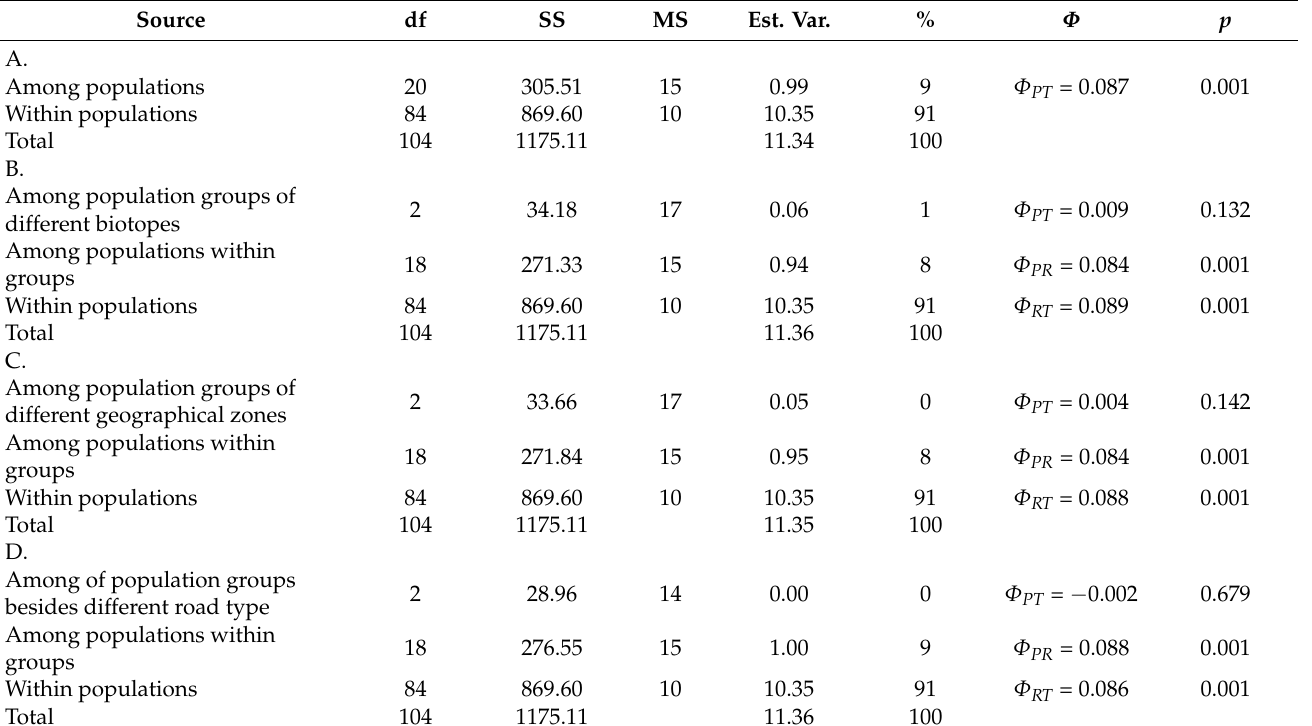
Table 3. Analysis of AFLP loci variance for small balsam ( Impatiens parviflora ) populations. A . Two- level analysis. B – D . Three-level analyses, differentiation of populations in relation to biotope ( B ), geographical zone ( C ), and road type ( D ).